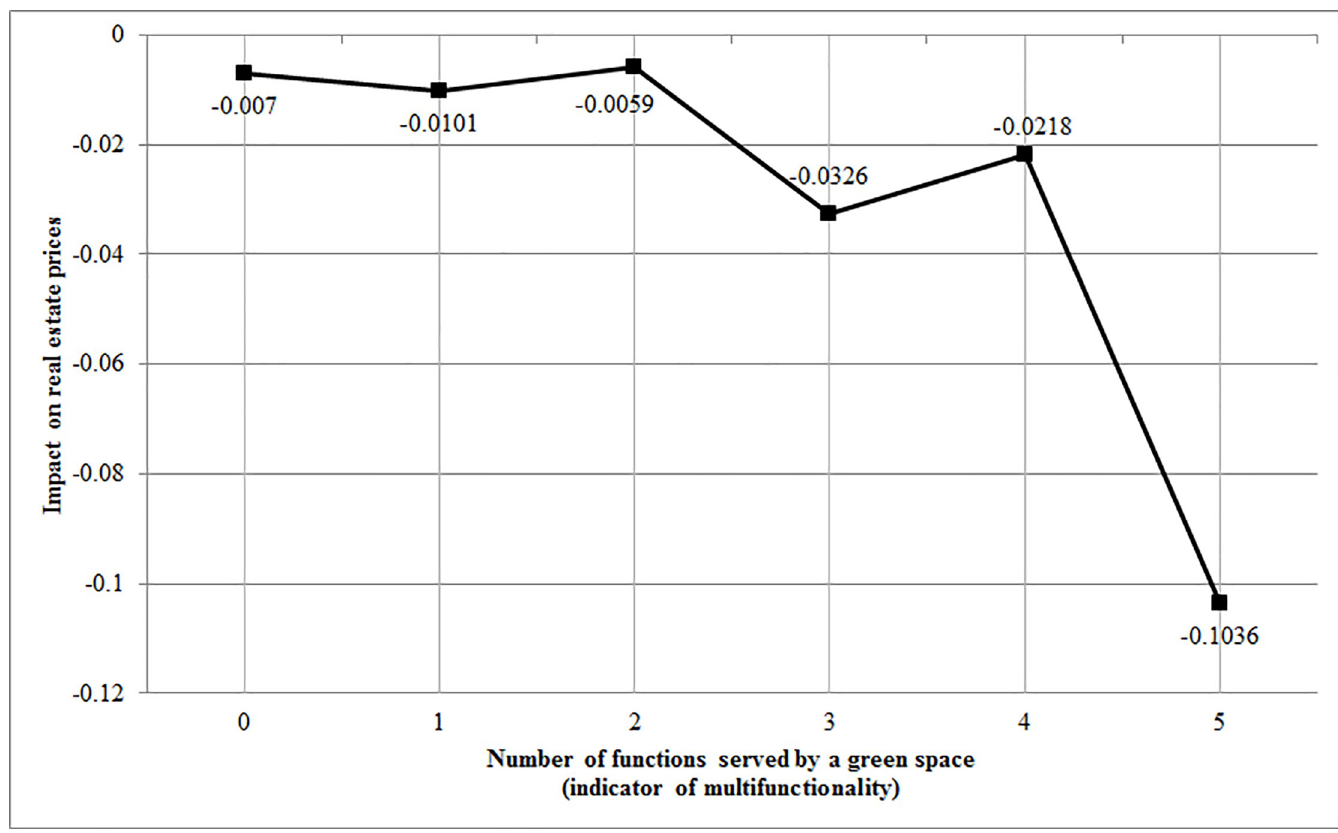
Fig 1. Fall in the price of real estate in reaction to an increase in the distance to a green space characterized by a given level of multifunctionality.